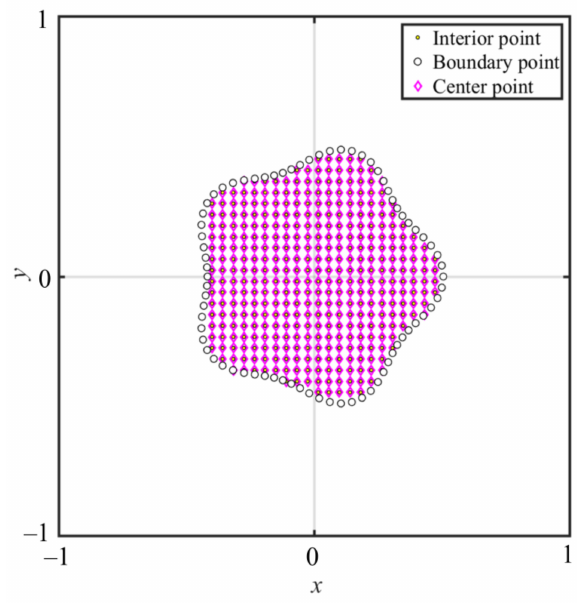
Figure 17. The conventional RBFCM collocation scheme.